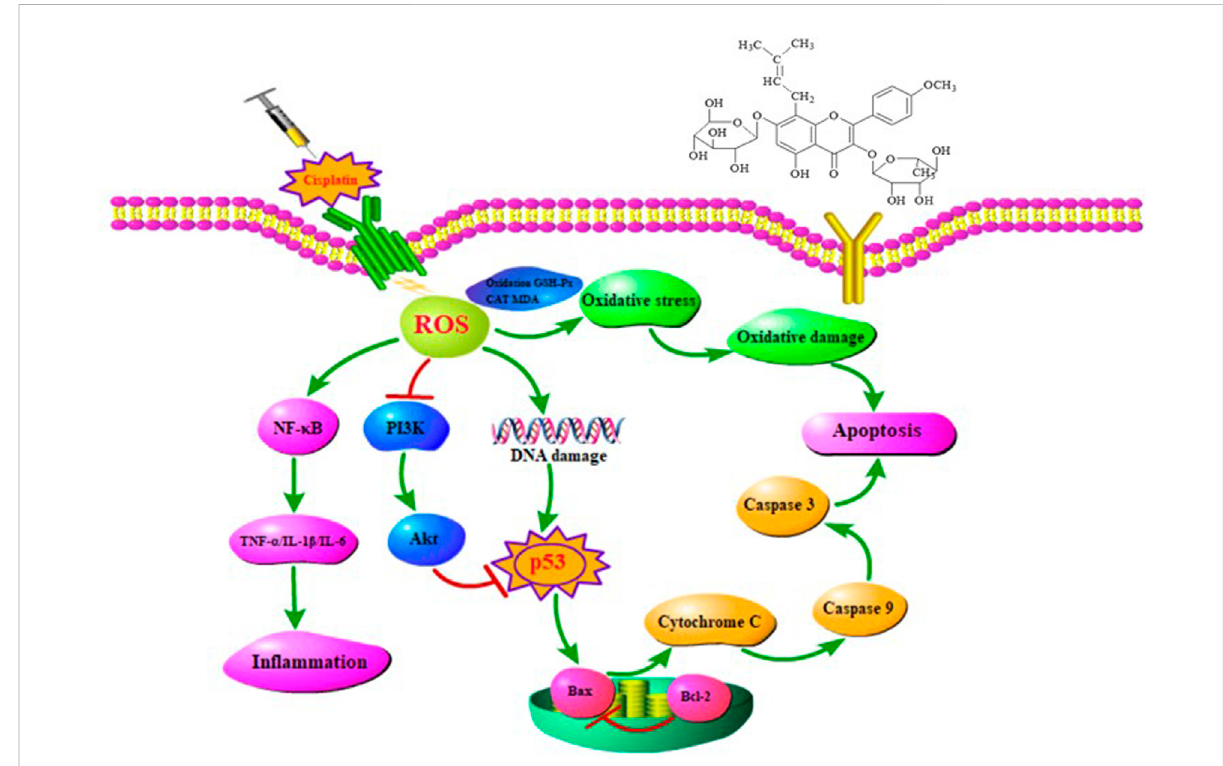
FIGURE 7 The mechanism of EFE attenuates cisplatin-induced intestinal injury in